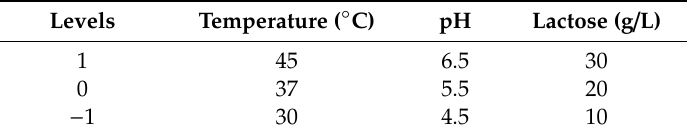
Table 1. Levels of independent factors used for full-factorial analysis.